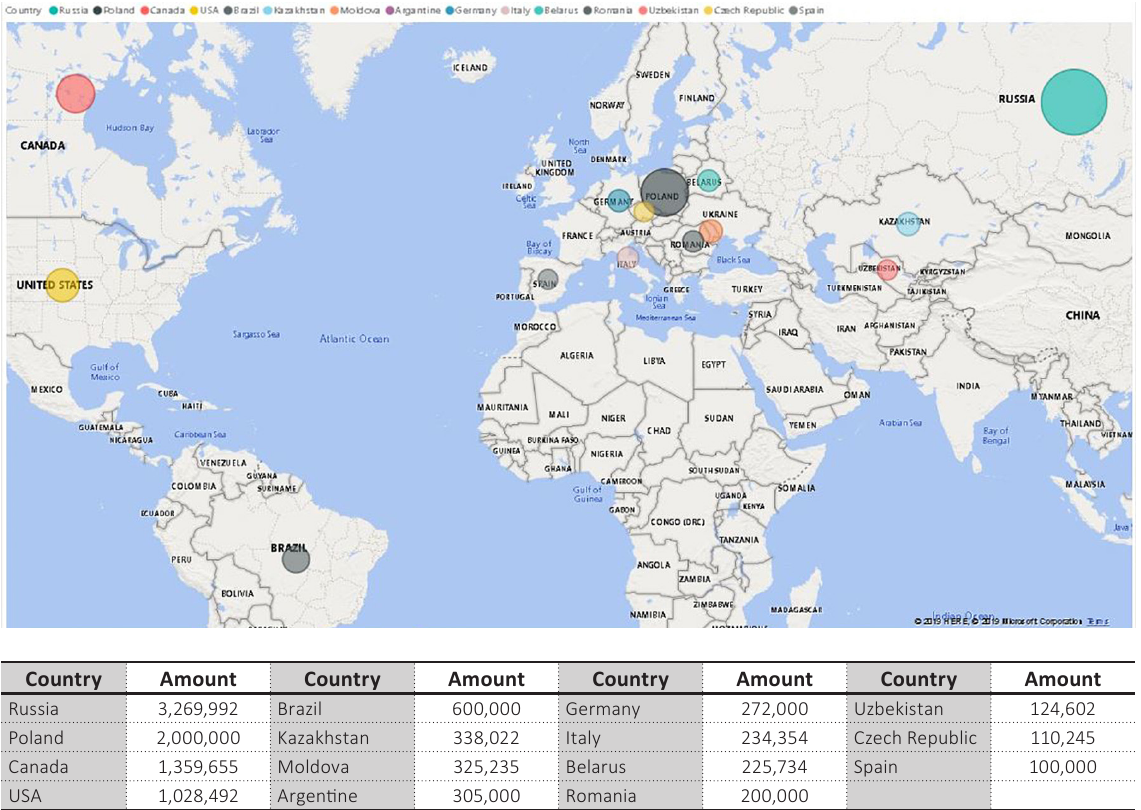
Figure 3. The number of the Ukrainian diaspora in the world and its visualization in Power